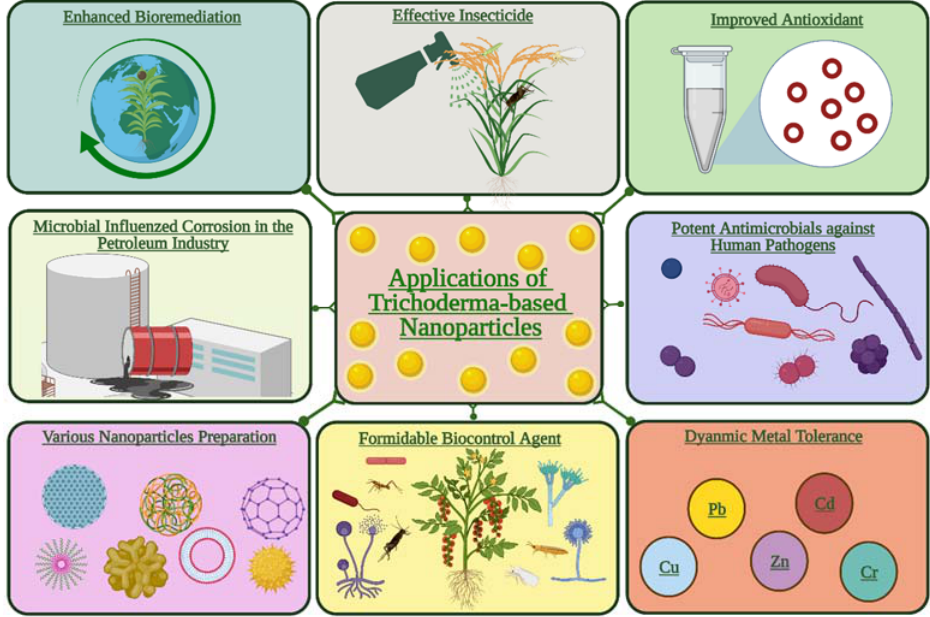
Figure 4. Various potential applications of Trichoderma ‐ mediated nanoparticles in agroecosystems. The present figure was created by BioRender.com.